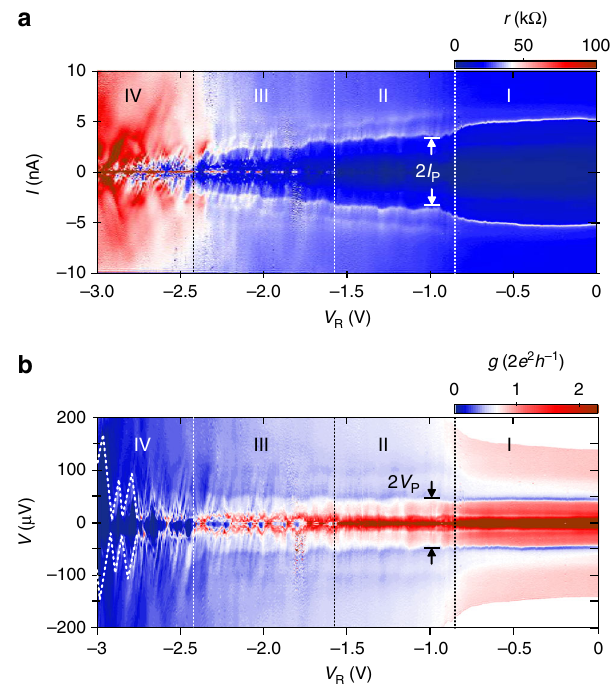
Fig. 2 Transport regimes in the constriction. a Differential resistance r versus current I for gate voltage V R = 0 to − 3 V. Gate L is kept at V L = − 1 V. The four regimes of transport I to IV are indicated. I P , reminiscent of the critical current I c of the weak link, is indicated. b Same data as in a but with voltage drop V on the vertical axis and differential conductance g represented by the color scale. V P denotes the voltage drop at I P . Dotted lines in regime IV indicate conductance